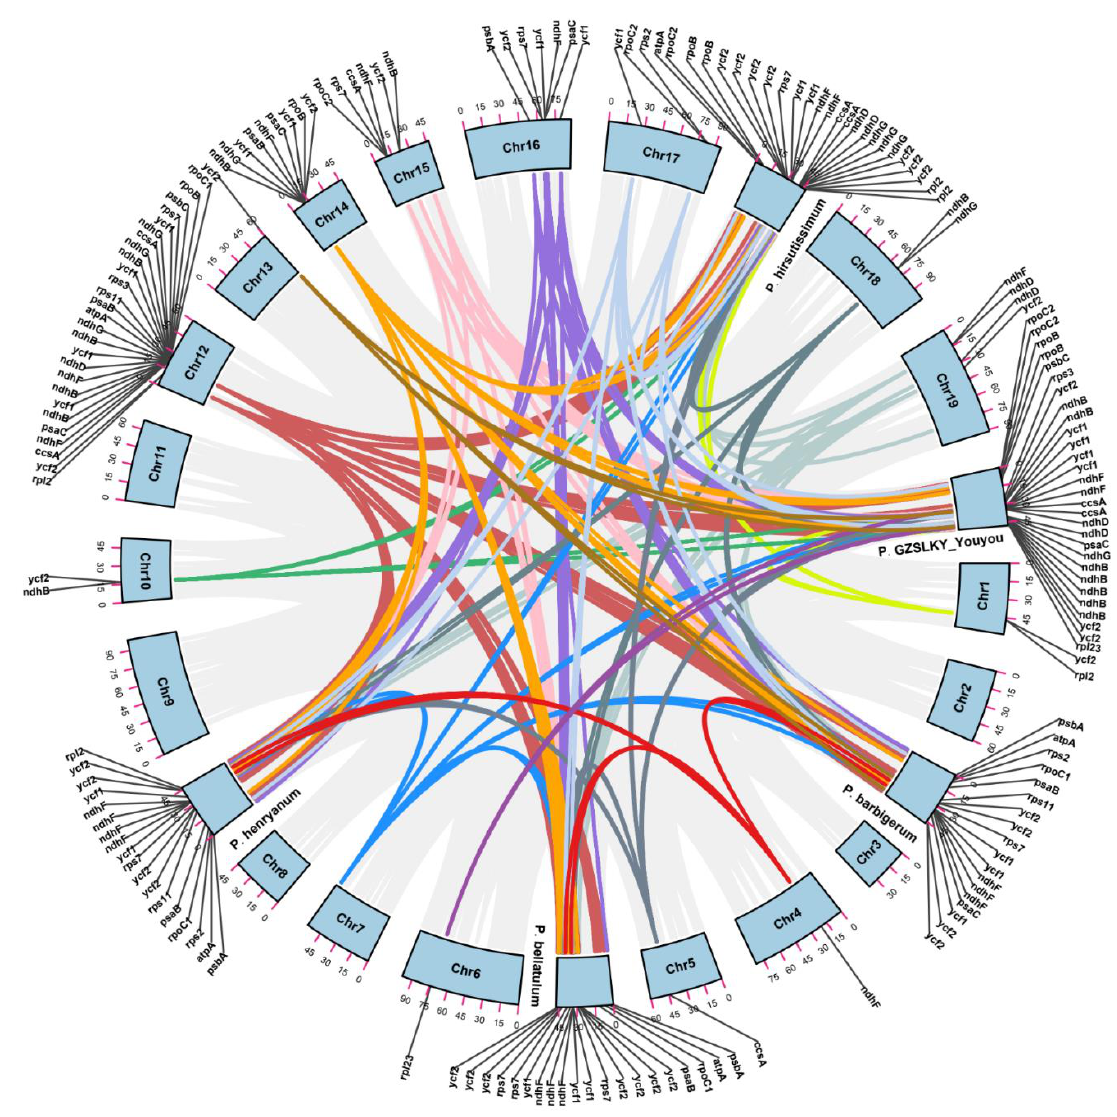
Figure 5. Circle plot for genome-wide synteny analysis between chloroplast and nuclear genomes. Colored lines representing homologous gene fragments (E value: 10-5, Identity > 99%) share the two different types of genomes. Different colors correspond to each specific chromosome. The lengths of these genomes were scaled and standardized.